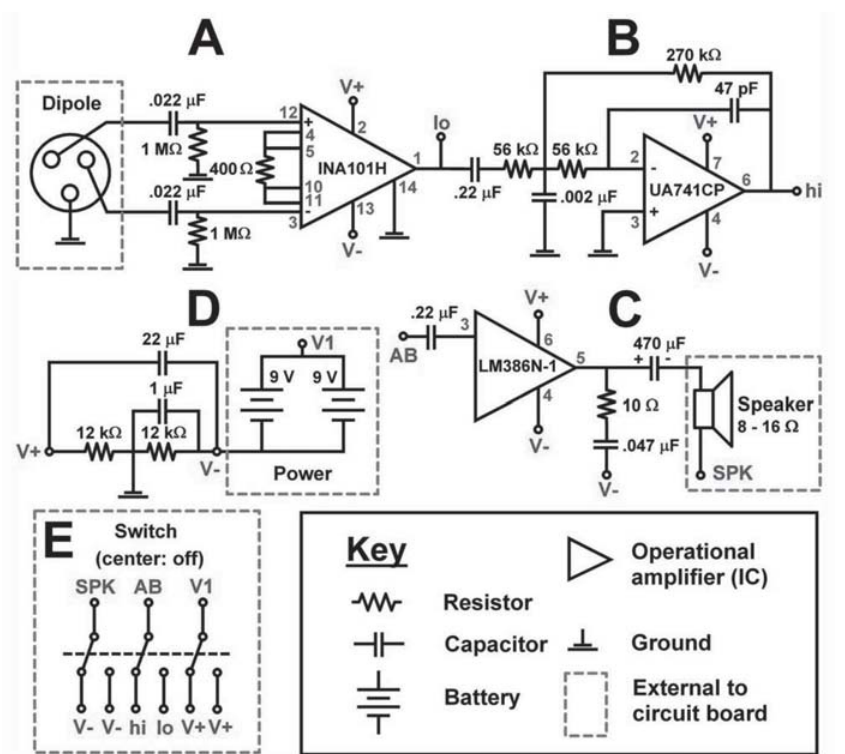
Fig. 1. Circuit plan for Electric Fish Finder. See text for description of stages A - E. Boxes with dashed lines refer to components external to circuit board. IC = integrated